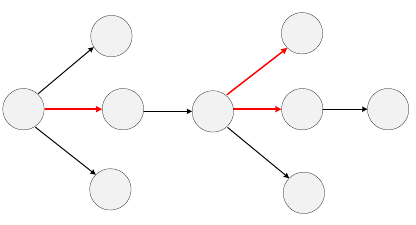
Figure 2. The observed COVID-19 transmission network. The red edges are abnormal transmission relations with undetected nodes in